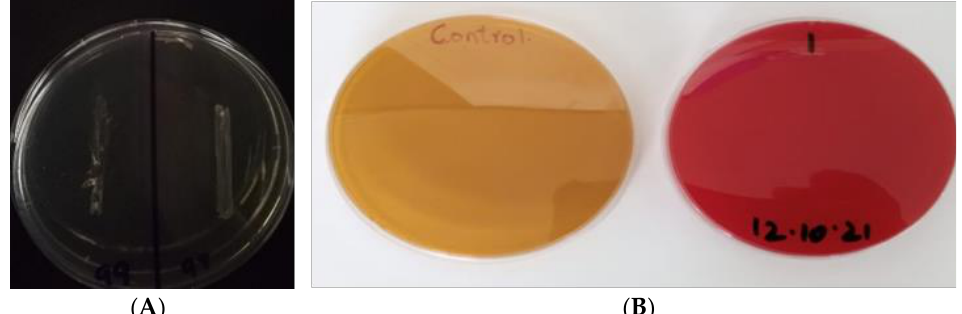
Figure 6. Safety profile: ( A ) DNAs; ( B ) Hemolytic activity. The test plates inoculated with all the isolates studied revealed white zones. Table 3. Hemolytic and bile salt hydrolyzing (BSH) potential of the isolated LAB strains. DNAs NMCC Strain BSH Hemolytic Activity DNAs + Gama -